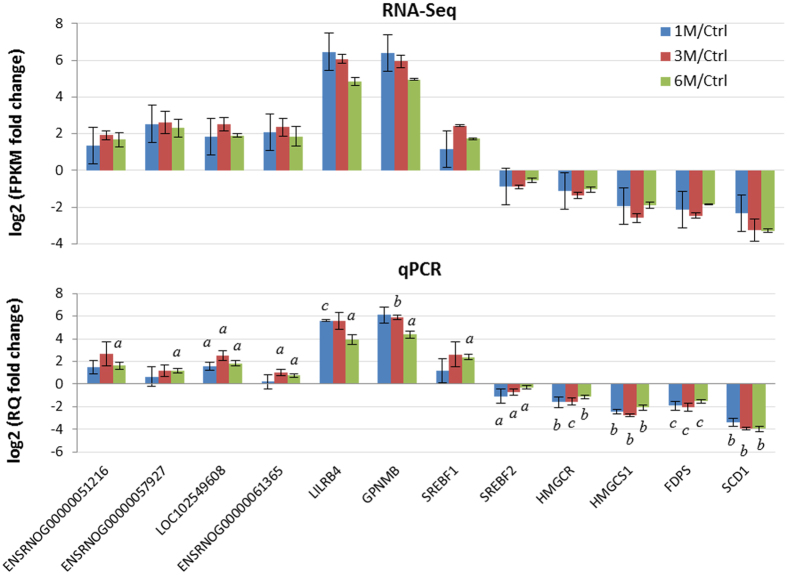
Verification of differential expression of selected genes by qPCR.Upper panel: Log2 FPKM fold-change in expression analyzed by RNA-Seq, calculated as the ratio of average FPKM of each time point to the control. Lower panel: Relative log2 of relative quantitation (RQ) fold-change in gene expression determined by qPCR, calculated using the 2−ΔΔCt method. a: p < 0.05, b: p < 0.01, c: p < 0.001, compared to control using Student’s t-test. Data were shown as mean ± SD (n = 3).